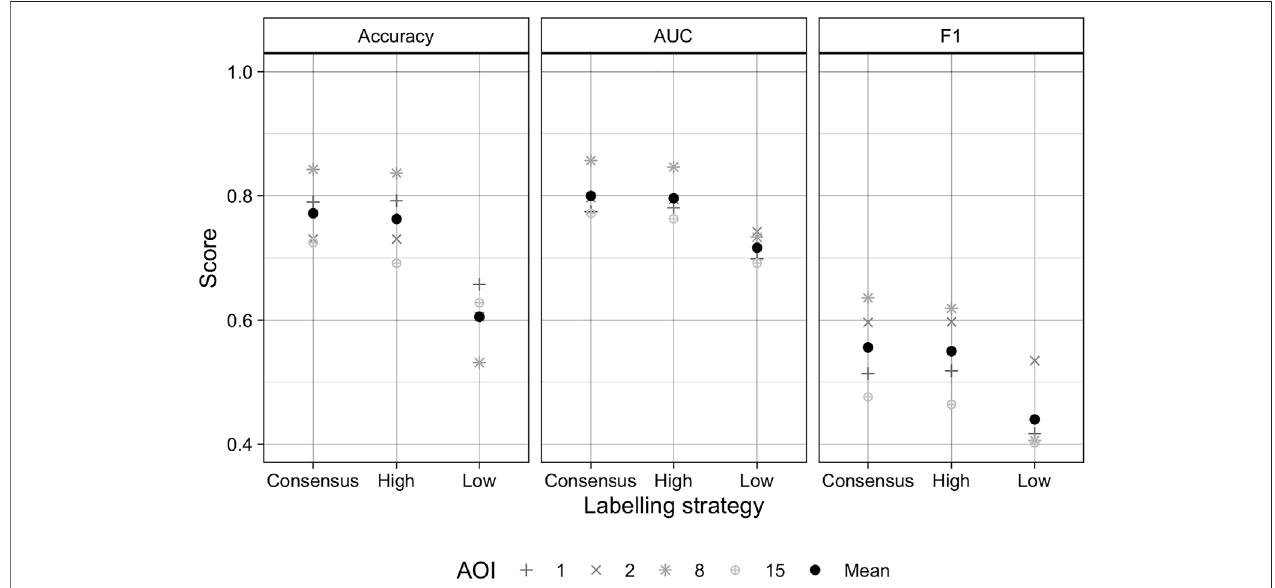
FIGURE 5 | Scores for overall accuracy, area under the curve of the Receiver Operating Characteristic, and the F1 score resulting from models trained with consensus labels, and labels made by the most and least accurate labellers to map each site. Comparisons were made for AOIs 1, 2, 8, and 15, denoted by grey symbols, while the mean scores across these AOIs are shown for each